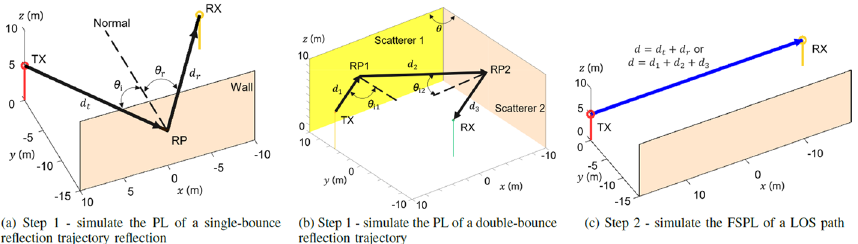
Fig. 4 MATLAB-based simulation steps to get the RL of single- and double-bounce